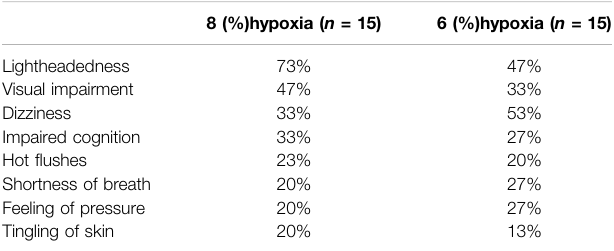
TABLE 1 | Reported symptoms after hypoxia